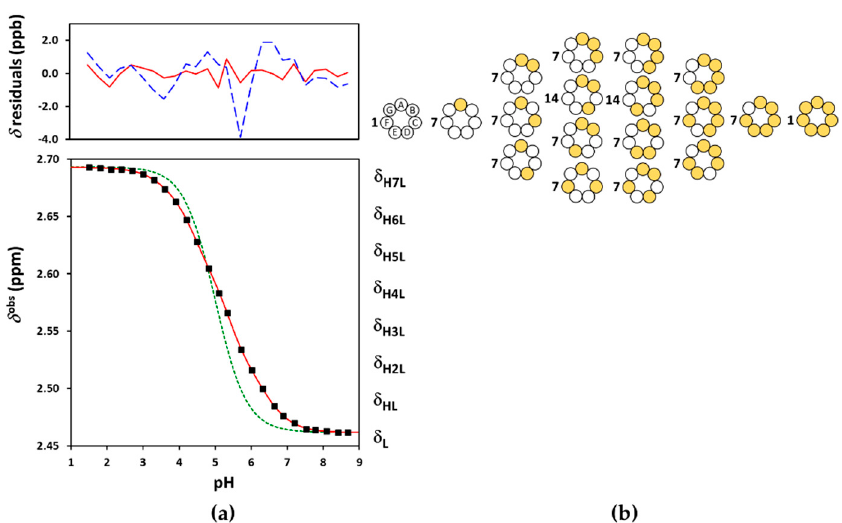
Figure 5. ( a ) The experimental NMR-pH titration curve of Su β -CD 8-CH 2 protons in squares. The green dashed line is generated by fitting the site-binding model without p ε , while the solid red line represents the fits by the ED-macro, Q-fitting or the single-p ε site-binding models. The residuals by the ED-macro or Q-fitting models given in solid red line, while those by the single- p ε microscopic evaluation by dashed blue line above; ( b ) the reduced microscopic protonation scheme of Su β -CD, with multiplicities of the protonation isomers, where white circles indicate deprotonated-, and the yellow circles denote protonated binding